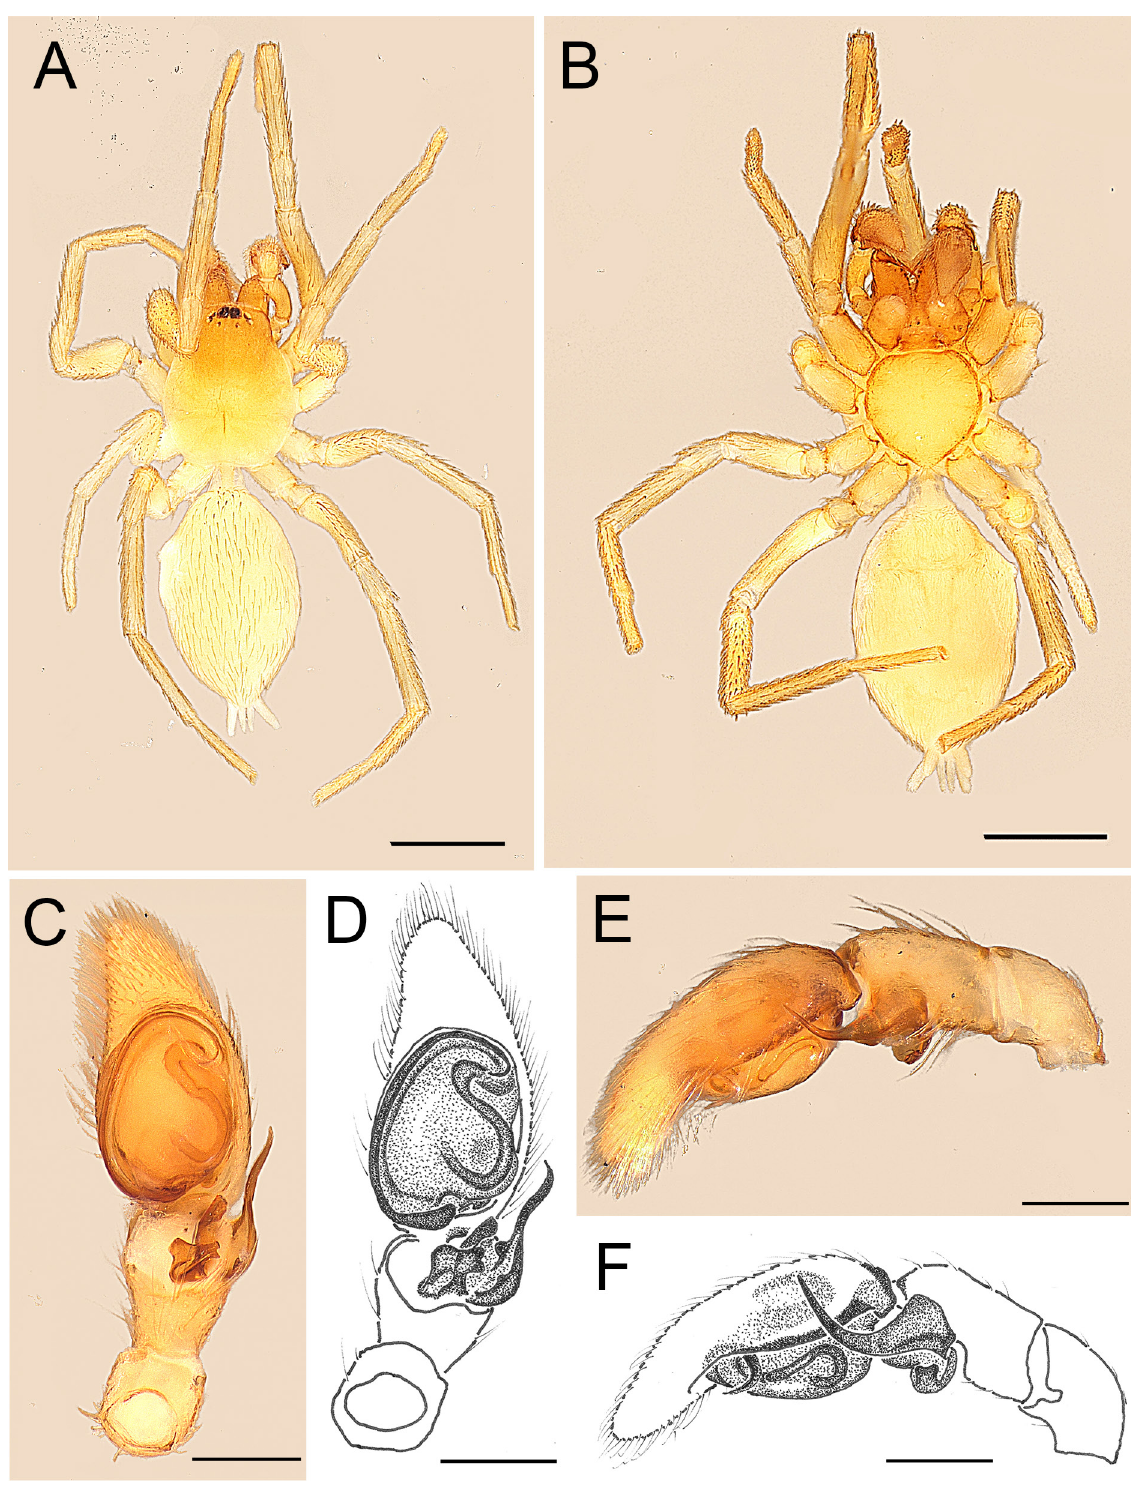
Fig. 13. Andromma cycnotrachelos sp. nov., ♂, holotype (BE_RMCA_ARA.Ara 247532). A . Habitus, dorsal view. B . Same, ventral view. C–D . Left palp, ventral view. E–F . Same, retrolateral view. Scale bars: A–B = 1 mm; C–F =